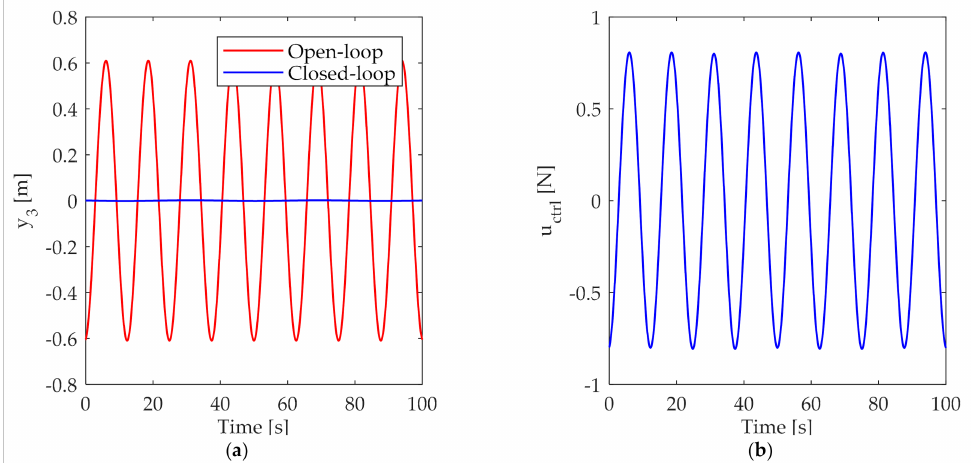
Figure 12. The steady-state response of the open-loop and closed-loop system ( a ) and the control force with the mldivide gains ( b ).